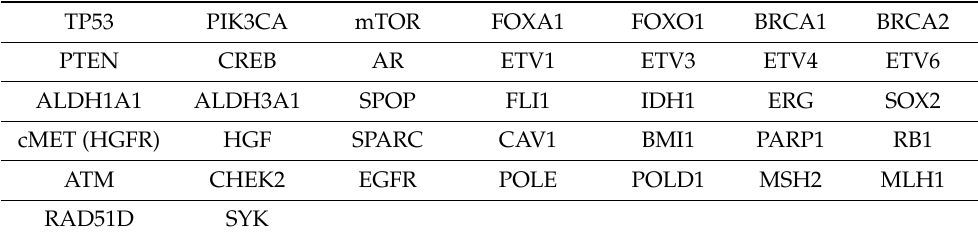
Table 2. Genetic panel for bioinformatics